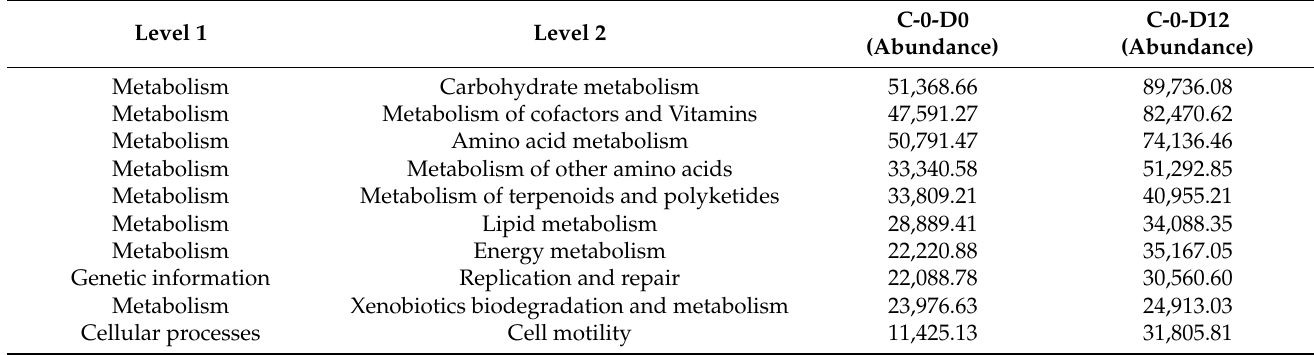
Table 3. The different abundance of function (Top10).